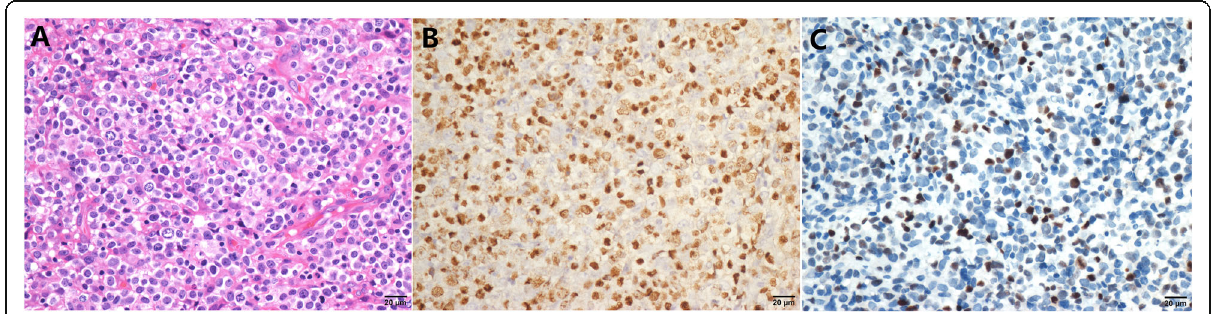
Fig. 2 P63 expression in EBV+ DLBCL. a HE staining of EBV+ DLBCL. b EBV in situ hybridization showed positive results. c P63 expression score was “ 6 ” in this case, for the proportion was “ 2 for 26%-50% ” and staining intensity was “ 3 for brown